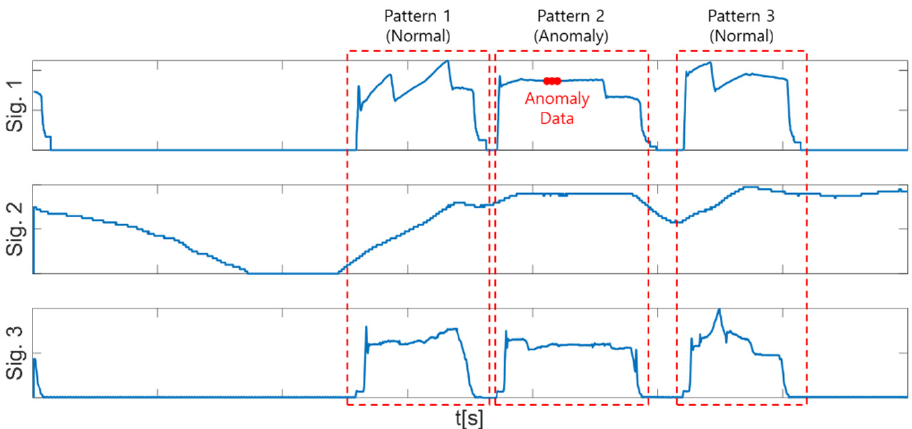
Figure 3. An example of target data section extraction (pattern extraction).